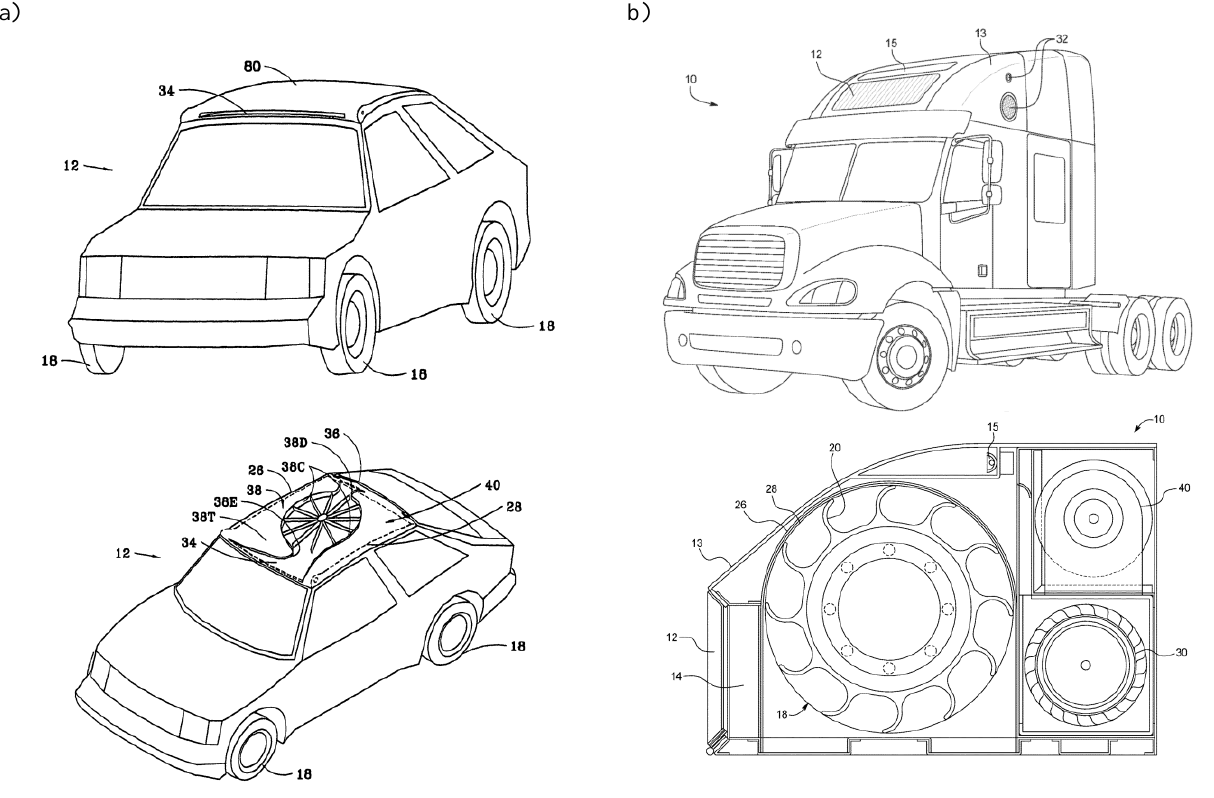
Fig. 5. Systems for harnessing wind energy: a) US Patent 10358038B1 [35], b) US Patent 10655604B1 [36]